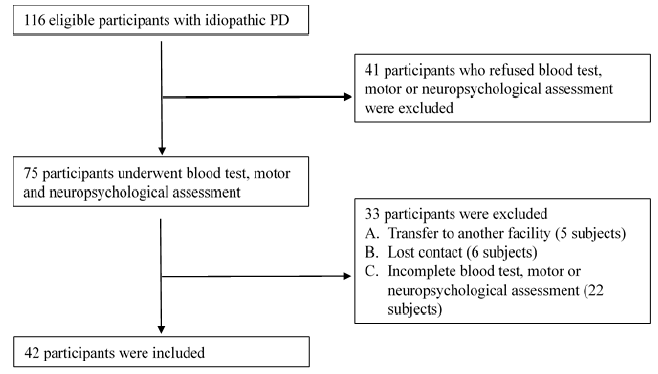
Figure 1. Exclusion flow